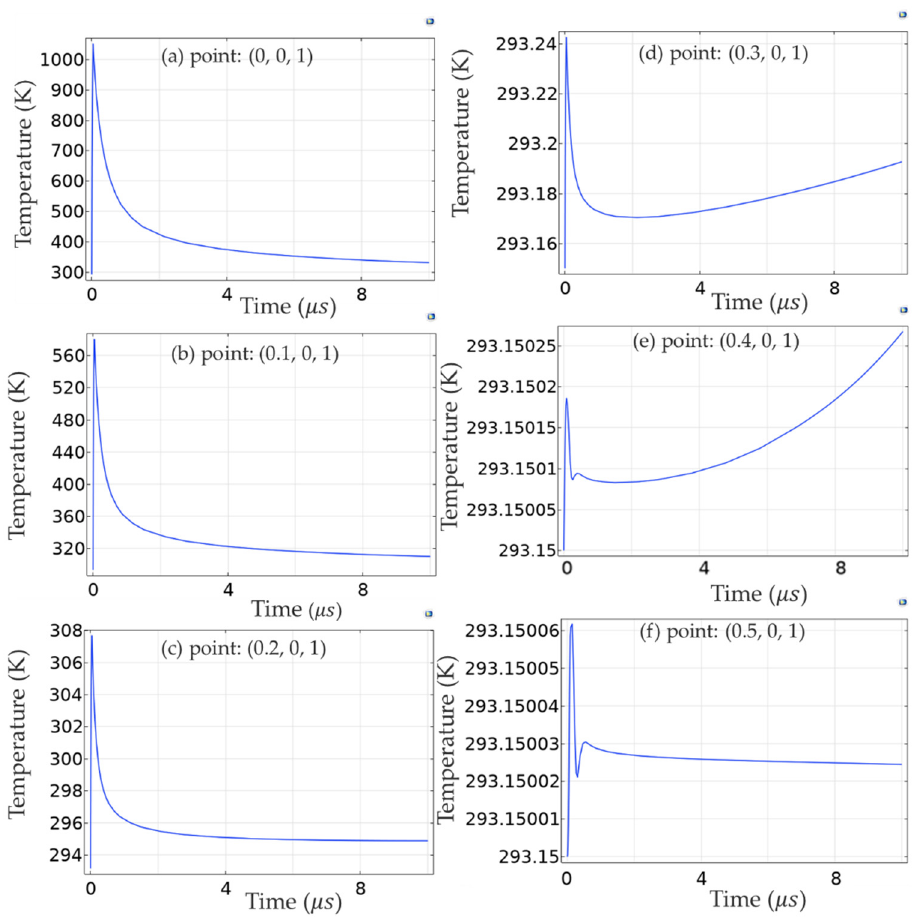
Figure 4. The temperature changes vs. time in different points on the silicon surface in model 1.